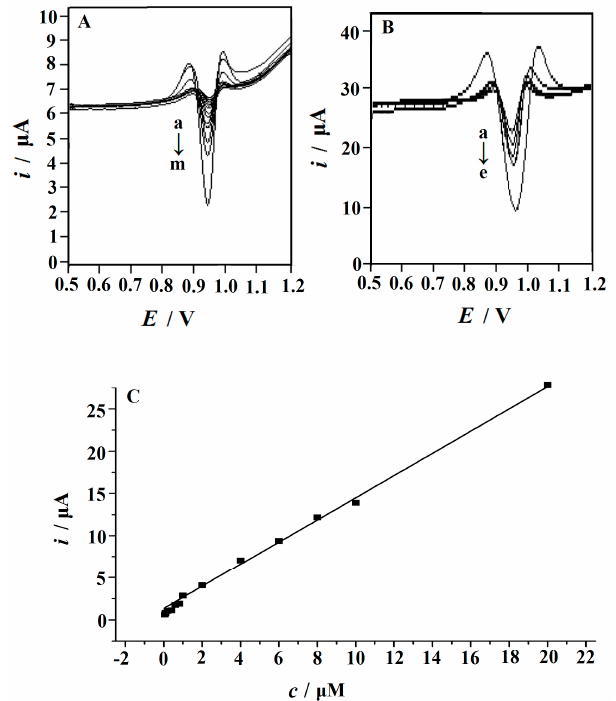
Figure 8. ( A ) Second-order derivative linear scan voltammograms obtained with the Cu 2 O NPs-ERGO / GCE in a 0.15 mol / L HAc–NaAc bu ff er (pH 6.6) containing di ff erent concentrations of RhB. From a to e : 4.0, 6.0, 8.0, 10, and 20 µ M. The insets show the voltammograms at low concentrations (from a to m ): 0.01, 0.02, 0.04, 0.06, 0.08, 0.1, 0.2, 0.4, 0.6, 0.8, 1.0, 2.0, and 4.0 µ M. ( B ) The calibration plots of the concentration of RhB versus peak current. Accumulation potential: − 0.1 V; accumulation time: 120 s, scan rate: 0.1 V s − 1 . Table 1. Comparison of di ff erent modified electrodes for